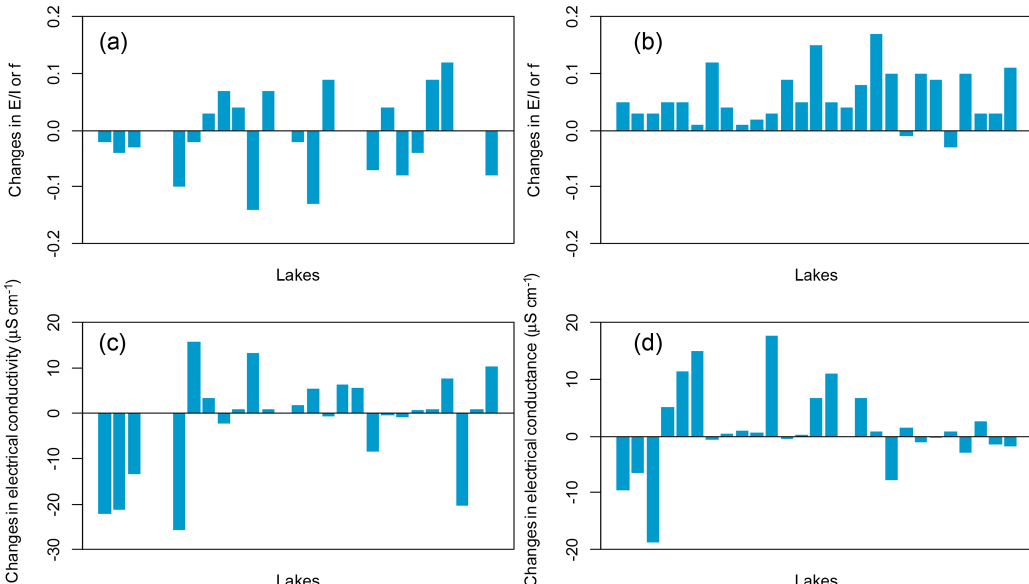
Figure A2. Changes in E/I or f between June 2013 and June 2014 ( E/I or f 2014 to E/I or f 2013) (a) , changes in E/I or f between August 2014 and June 2014 ( E/I or f August to E/I or f June) (b) , changes in specific conductance between June 2013 and June 2014 (EC 2014–EC 2013) (c) , and changes in electrical conductance between August 2014 and June 2014 (EC August–EC June) (d) . Lakes are organized along an elevation gradient (lower to higher